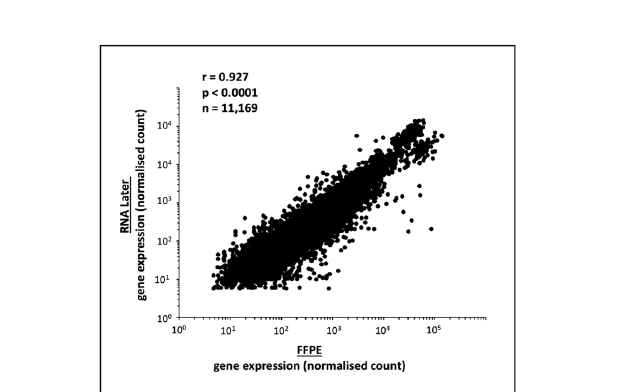
Figure 1. Correlation of gene expression between RNAlater samples and FFPE samples using the NanoString platform. The scatter plot shows expression results for up to 219 genes in 51 samples as quantified by Nanostring on the FFPE sample and corresponding RNAlater preserved biopsy. Statistic shows the Spearman rank correlation